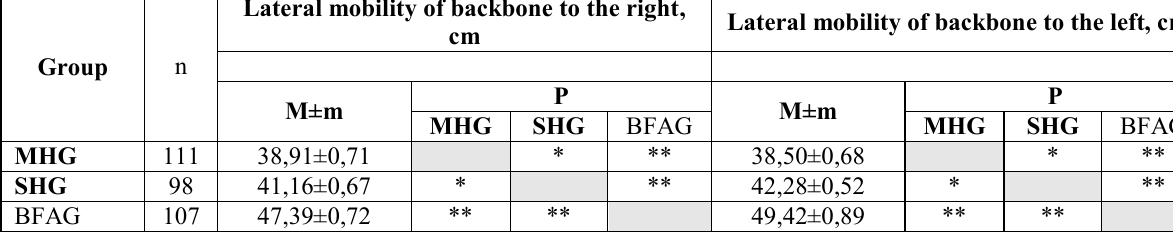
Functional state of backbone and muscular corset of different health groups’